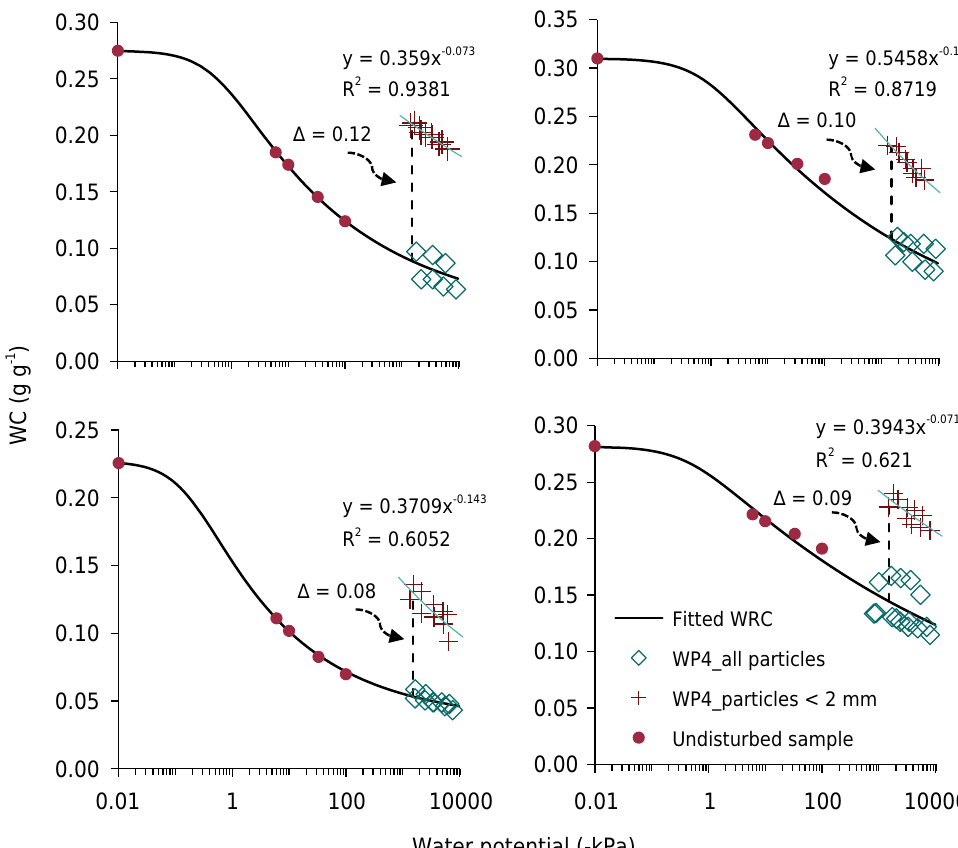
Figure 6. Water retention curve combining data from undisturbed and disturbed samples containing all particle sizes. Water retention of disturbed samples composed of only particles smaller than 2 mm were disregarded in the fitting procedure. Data from Pigatto et al.